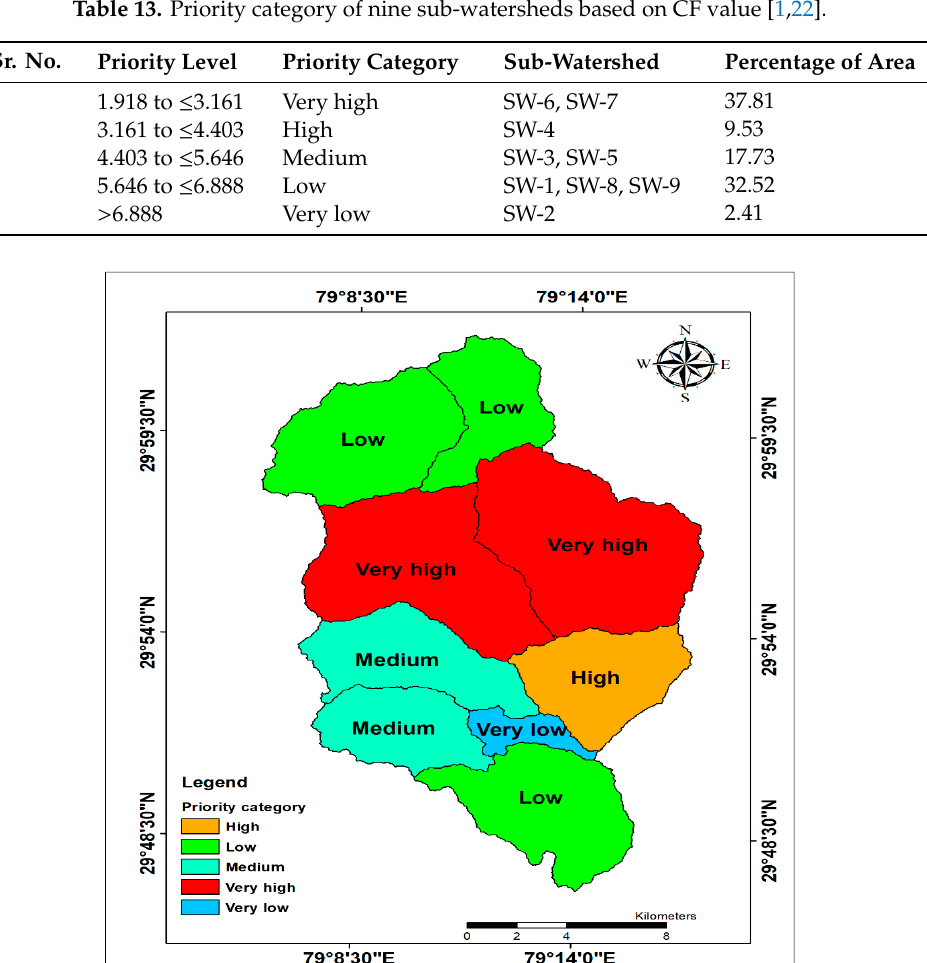
Figure 6. Map of final priority category of nine sub-watersheds of BW.